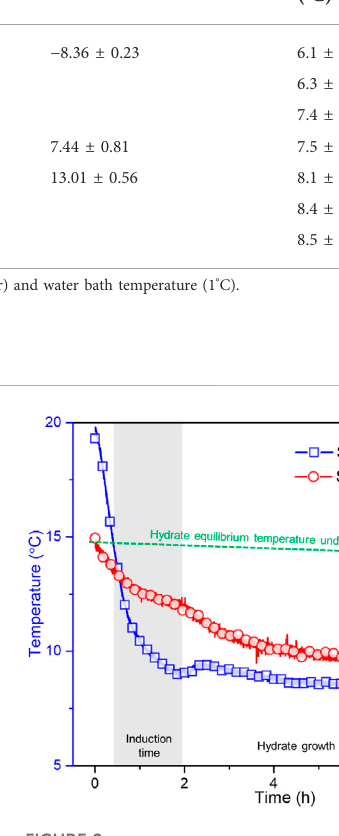
FIGURE 2 Variation trend of system temperature and pressure versus time during the experimental process of case 6. The hydrate equilibrium temperature under experimental pressure is calculated by the Chen-Guo model (Chen and Guo,